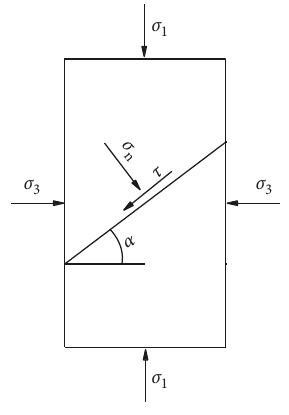
Figure 4: Mechanical models of fault